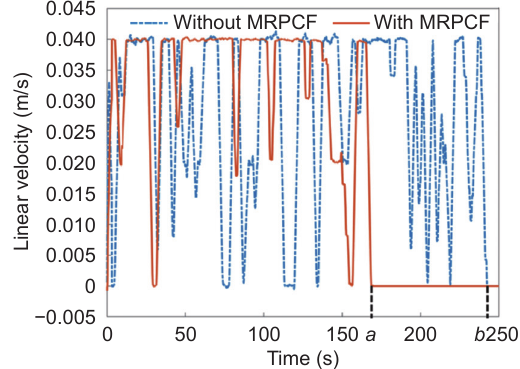
Fig. 8 Linear velocity profiles of the leader robot with and without MRPCF for a subject.